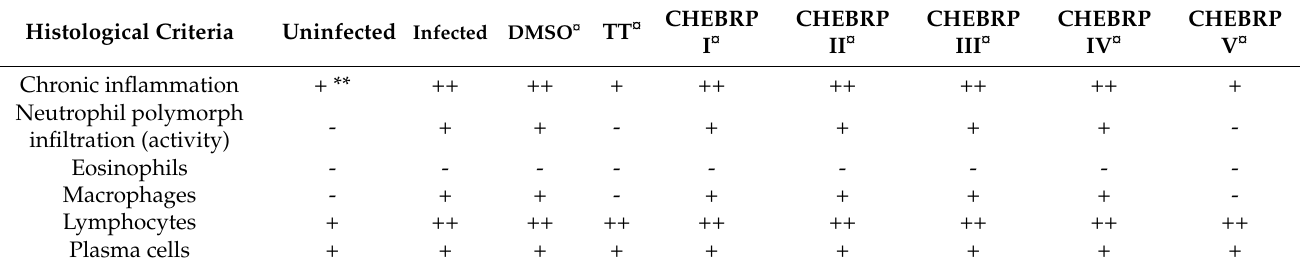
Table 3. Qualitative analyses of gastric tissue (antrum-pyloric) of the experimental groups during Helicobacter pylori (ATCC 43526) infection in